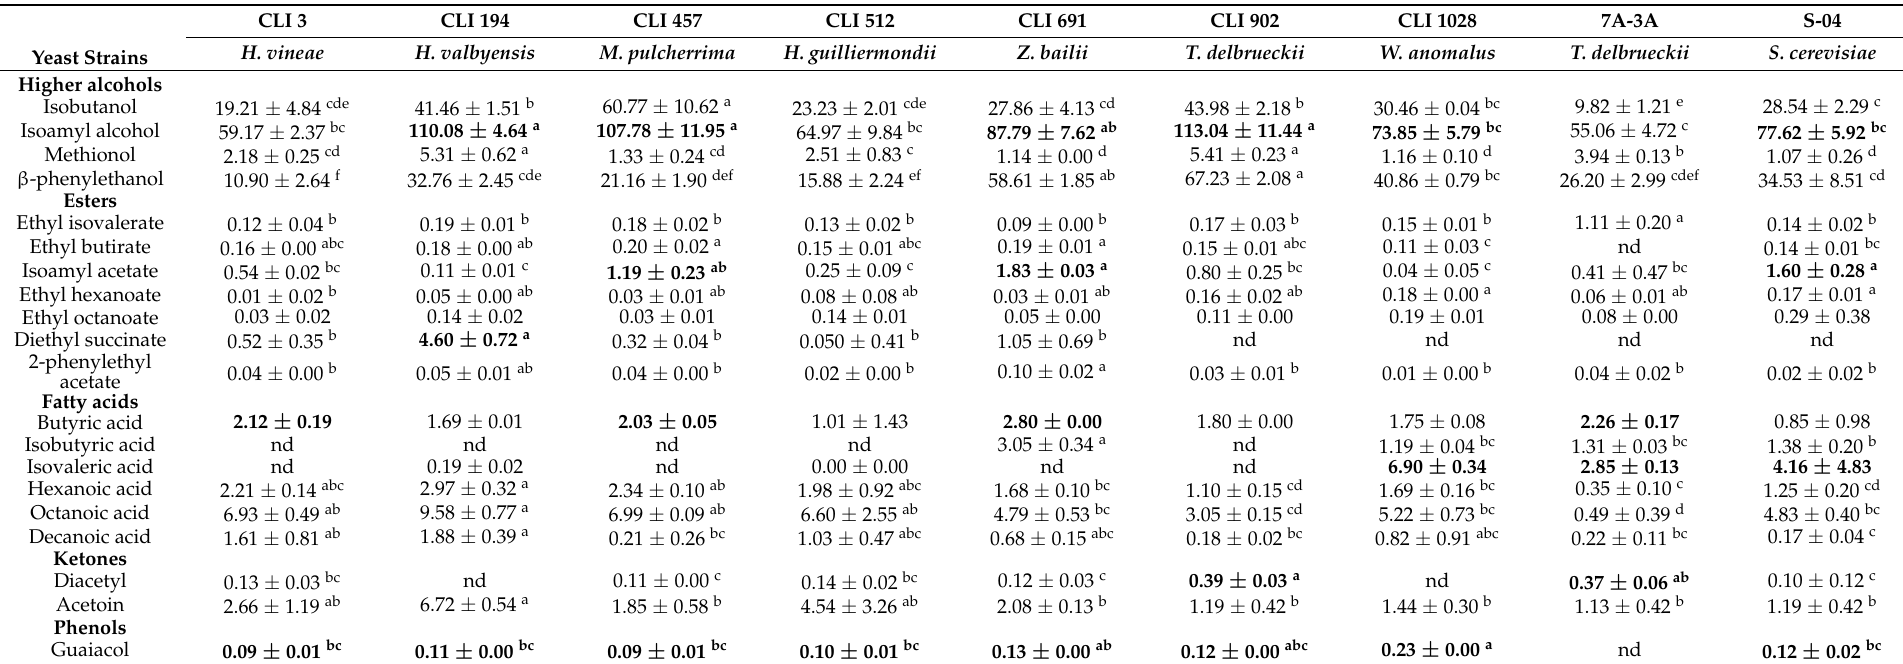
Table 6. Main volatile compounds found in beers fermented sequentially and in S-04 control